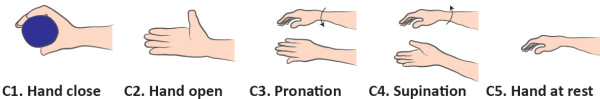
Motion classes used in mutex on-off control.